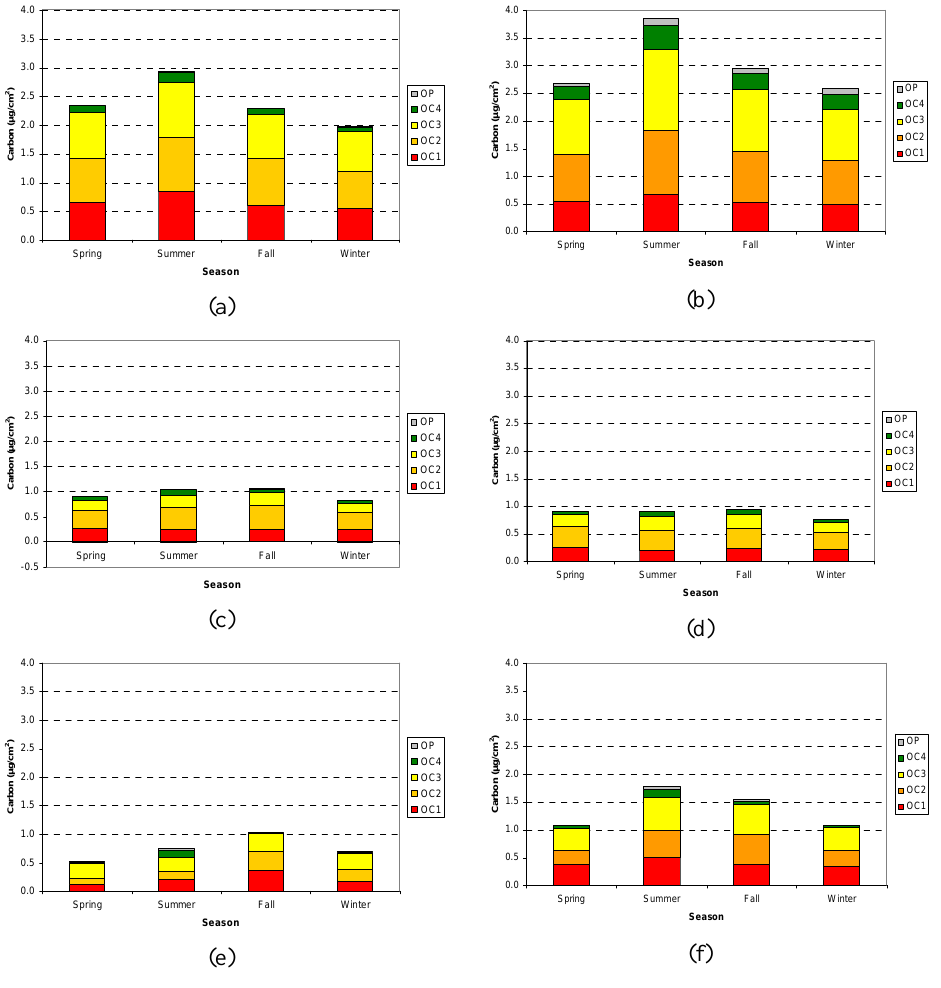
Figure 3. Fig. 3. Seasonal variations of blanks among: (a) IMPROVE field blanks (OC bQF ), (b) IMPROVE backup filters (OC QBQ ; six sites), (c) STN/CSN field blanks (OC bQF ), (d) STN/CSN trip blanks (OC tbQF ), (e) SEARCH denuded field blanks (OC dbQF ), and (f) SEARCH denuded backup filters (OC dQBQ ; eight sites). IMPROVE A protocol thermal carbon fractions are defined as OC1 (140 ◦ C), OC2 (280 ◦ C), OC3 (480 ◦ C), and OC4 (580 ◦ C) in 100% helium (He); and EC1 (580 ◦ C), EC2 (740 ◦ C), and EC3 (840 ◦ C) in 98% He/2% oxygen (O 2 ), and charring/pyrolysis carbon (OP; carbon evolved when reflectance returns to its initial value); OC = OC1 + OC2 + OC3 + OC4 + OP. EC levels (EC1 + EC2 + EC3 – OP) were negligible for blank and backup filters and are not plotted. Table 4. Average blank TC concentrations for the eight collocated IMPROVE–STN/CSN sites. Number of Pairs Field Blank TC Areal